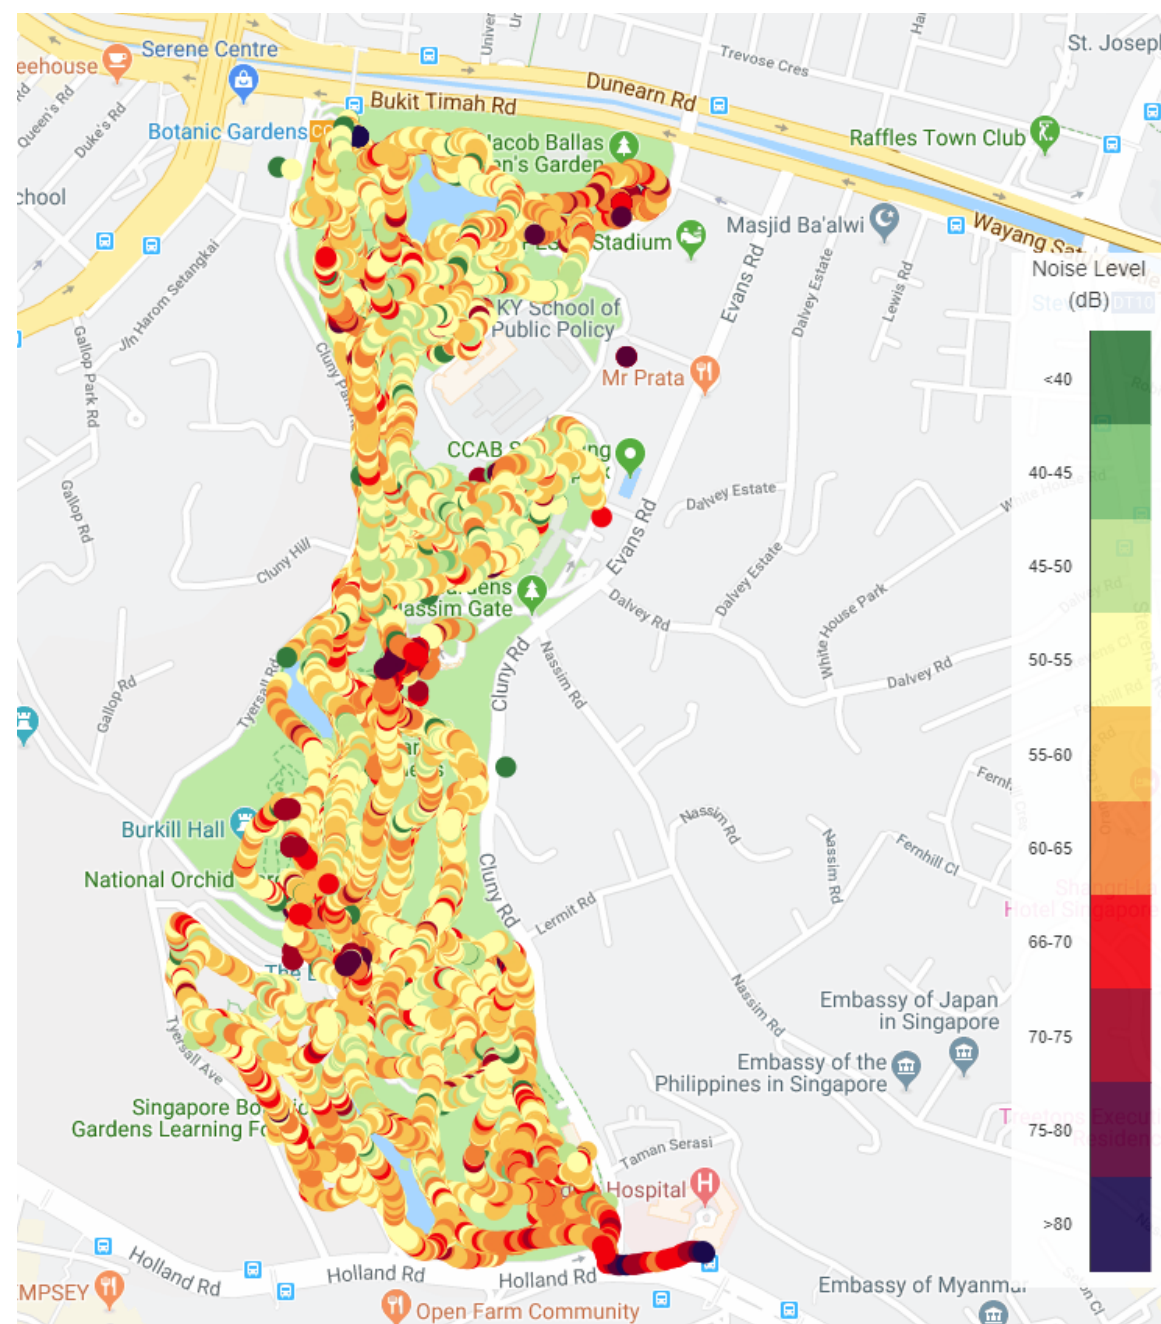
Figure 1: The overall noise map of the Singapore Botanic Gardens